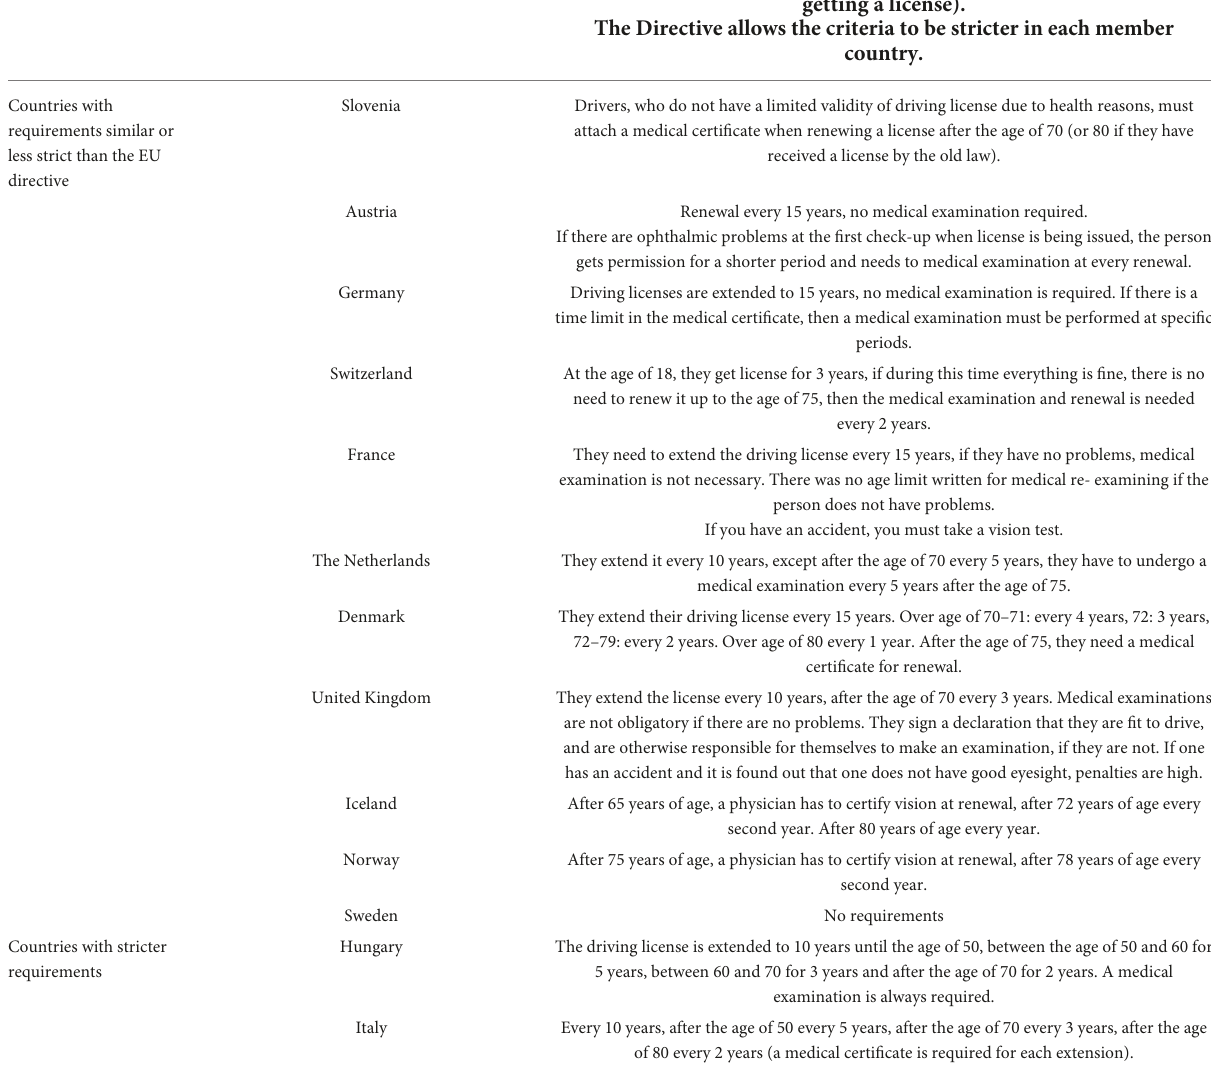
TABLE 4 Requirements of the European Directive on the renewal of driving licenses and vision check-ups and a comparison of the requirements of selected European countries according to the degree of deviation. EU Directive From 19/01/2013: The driving license is valid for 10 years. (2006/123/EC) Individual member countries may decide to extend it to 15 years. Member countries may require a medical examination (usually only if any medical restriction is identified at the first examination